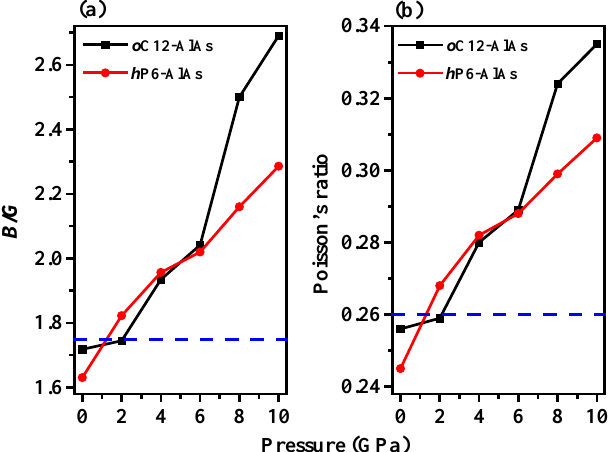
Figure 3. The ratio of bulk to shear modulus ( B / G ) ( a ) and Poisson’s ratio ( b ) of o C12-AlAs, h P6-AlAs, and diamond-AlAs as a function of pressure.